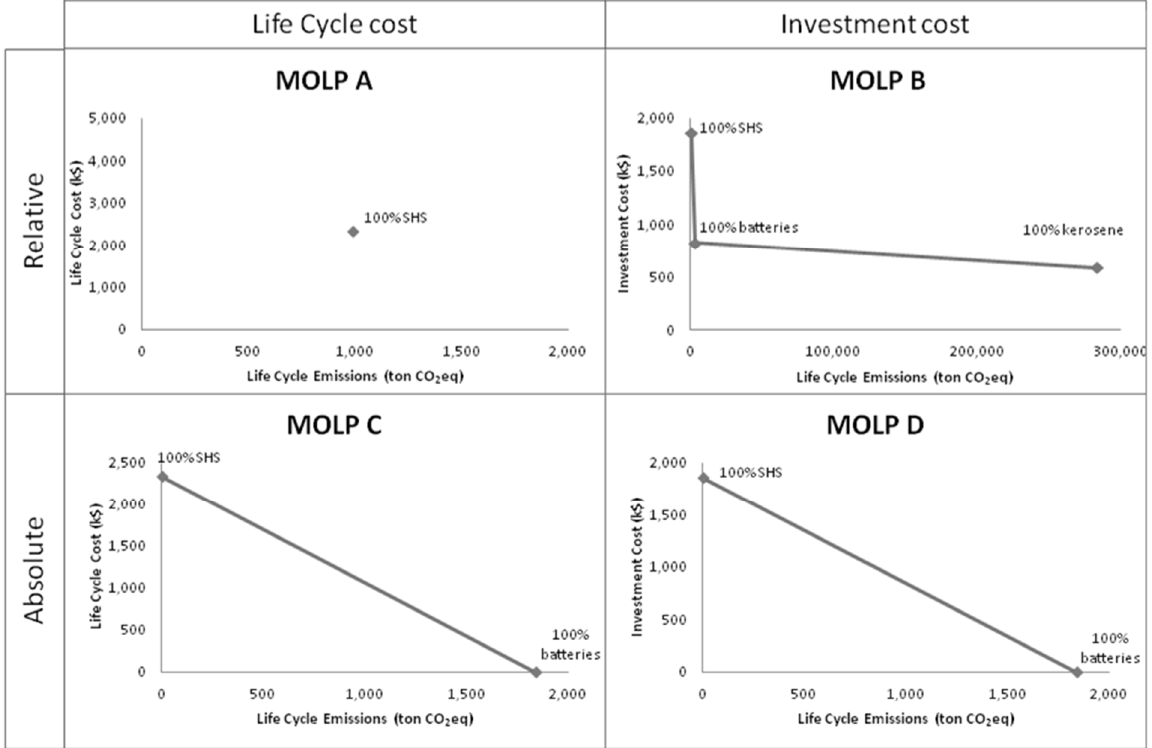
Figure 1. Optimal solution frontiers of the multi-objective linear programming (MOLP)